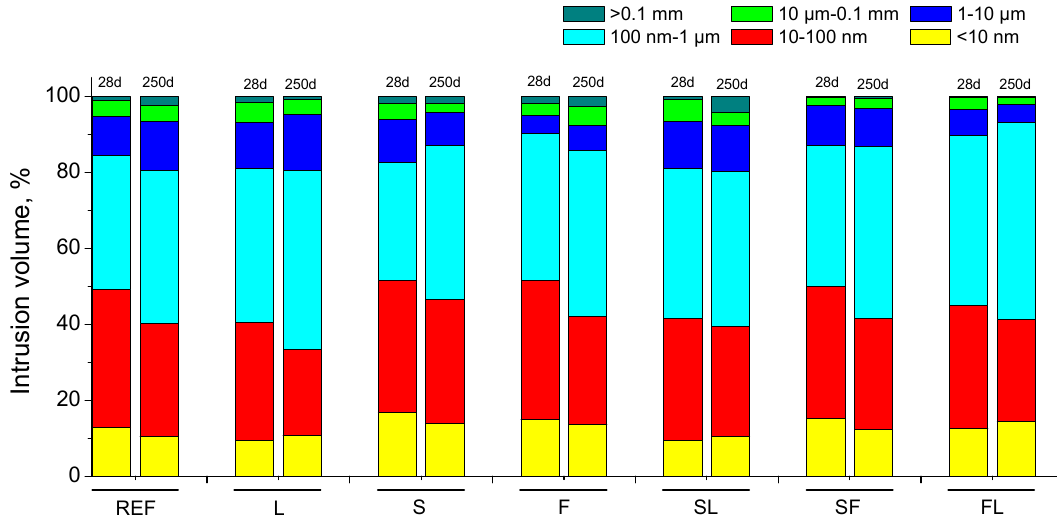
Figure 2. Pore size distributions noted for the analyzed binders.